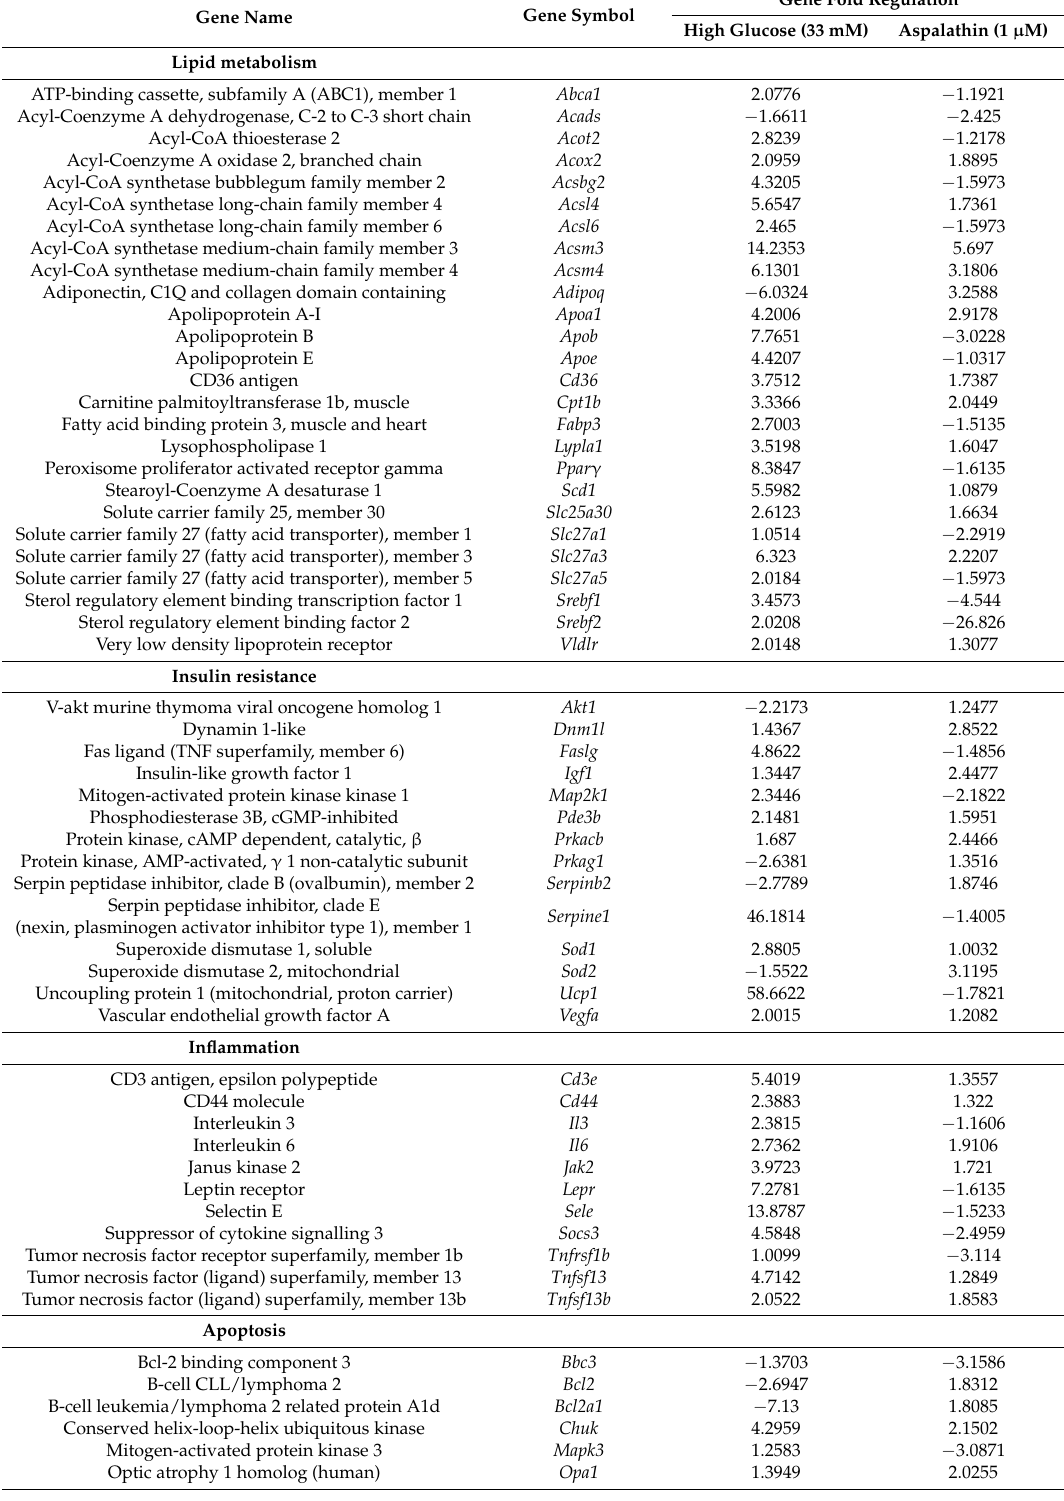
Table 2. Effect of aspalathin on the transcriptional profile of genes involved in metabolic